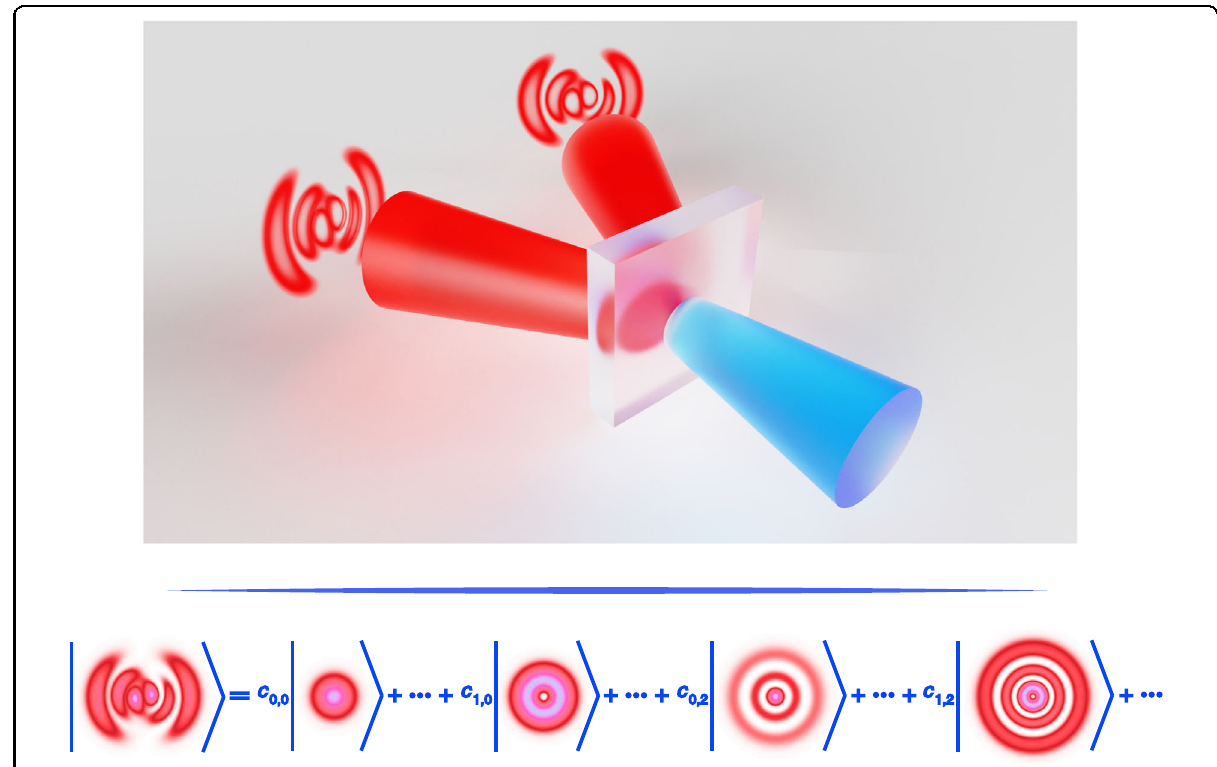
Fig. 4 A typical quantum toolbox. The core quantum toolbox (top panel) typically exploits the generation of entangled photons, shown in red, by spontaneous parametric downconversion (SPDC) of a high-energy photon (shown in blue), often using non-linear crystals. Expressing and controlling the entanglement in the spatial basis comprising patterns of light (bottom panel) allows for high-dimensional entanglement to be exploited in quantum protocols. The more patterns in the superposition, the higher the dimensionality of the quantum